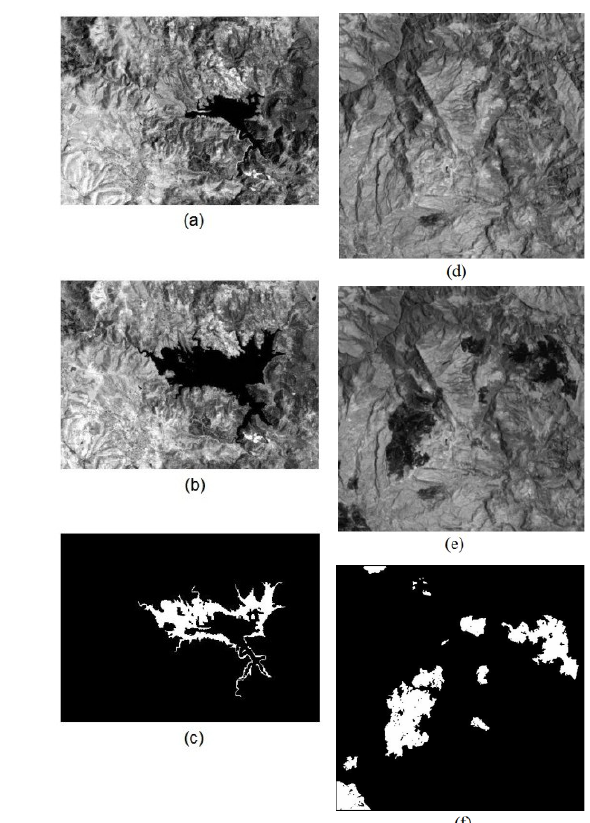
Table 3. The quantitative results of Sardinia Landsat 5 image data set.